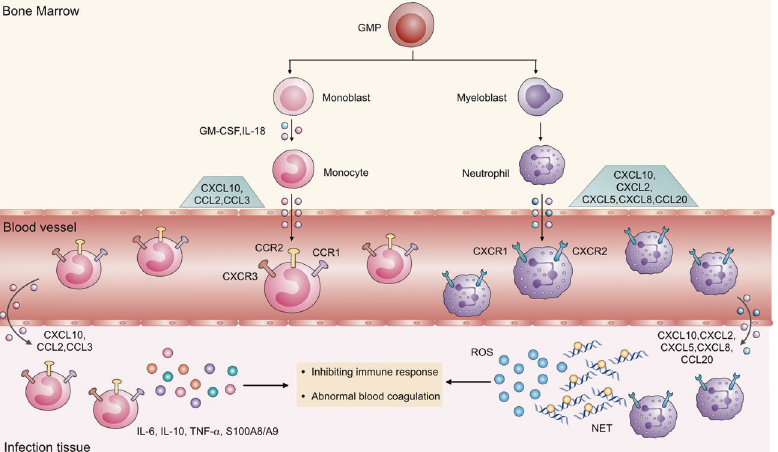
Fig. 2 The differentiation and recruitment of monocytes and neutrophils in COVID-19. The myeloblasts differentiate into neutrophils in the bone marrow and are then recruited by chemokines such as CXCL10, CXCL2, CXCL5, CXCL8, and CCL20 to the peripheral blood and infected tissues. Pro-monocytes differentiate into monocytes, which migrate into the peripheral blood and infected tissues by binding chemokines such as CXCL10, CCL2, and CCL3. In infected tissues, IL-6, IL-10, TNF- α , S100A8/A9, ROS, and NETs derived from neutrophils or monocytes were increased and inhibited the immune response to induce pneumonia and lead to blood coagulation